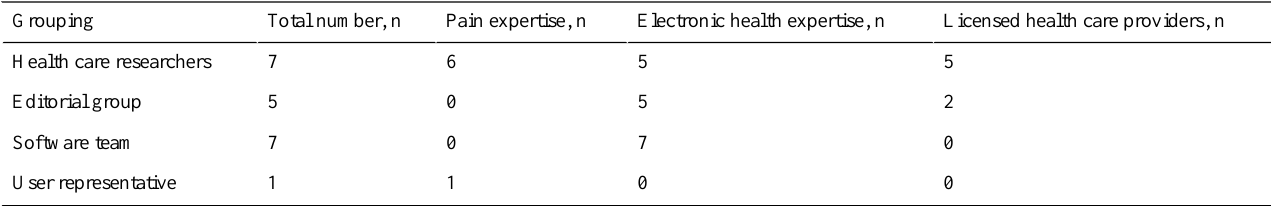
Table 1. Overview of multidisciplinary project team